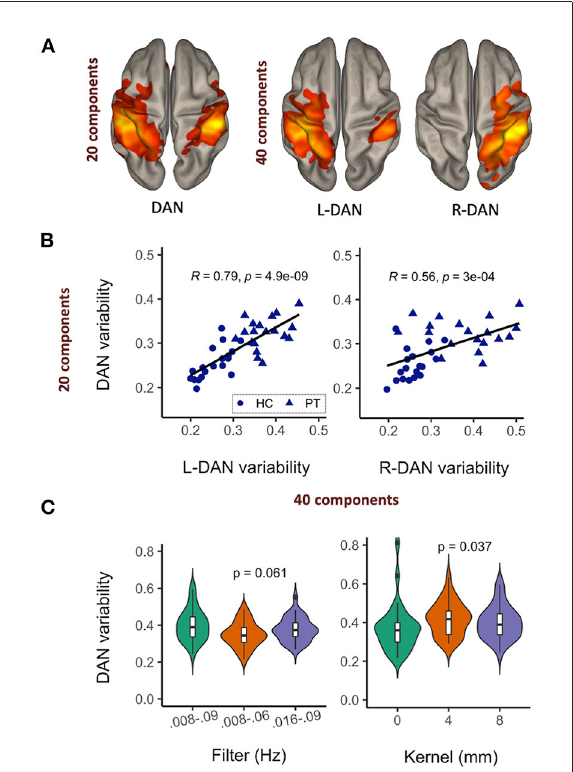
FIGURE2 Network variability is a reproducible and stable MR metric. Upon increasing the number of ICA components, the dorsal attention network (DAN) was reduced to left and right hemisphere sub-networks (A) , with corresponding variability metrics remaining significantly correlated (B) and relatively stable across different data filtering bandwidths and spatial smoothing kernels (C)